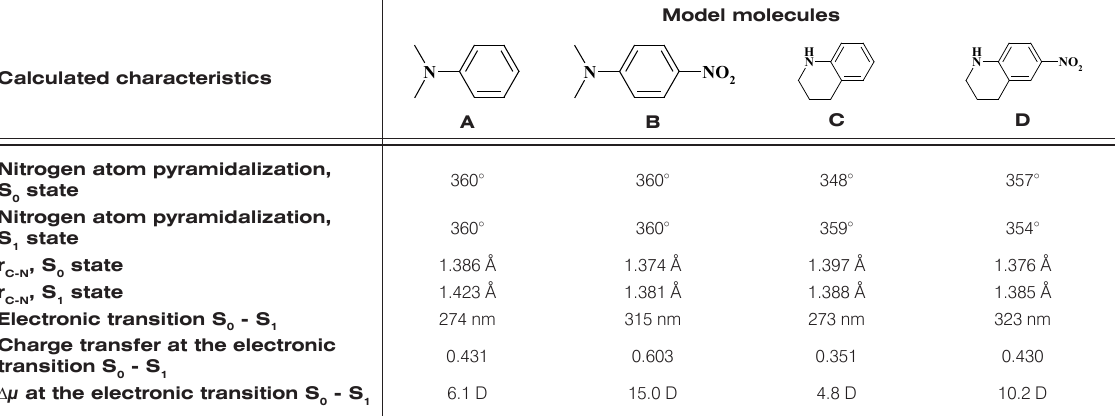
Table 2. Quantum-chemical modeling of the space structure and electronic effects of the trimethylene chain fixed alkylamino group.